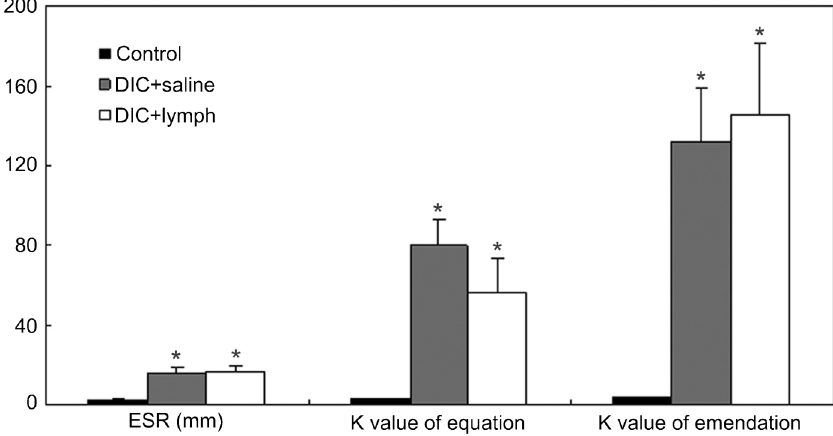
Figure 7. Changes of erythrocyte sedimentation rate (ESR) in the three rat groups studied. Data are reported as means ± SD for 10 rats. *P , 0.05 compared to the control group (one-way ANOVA).